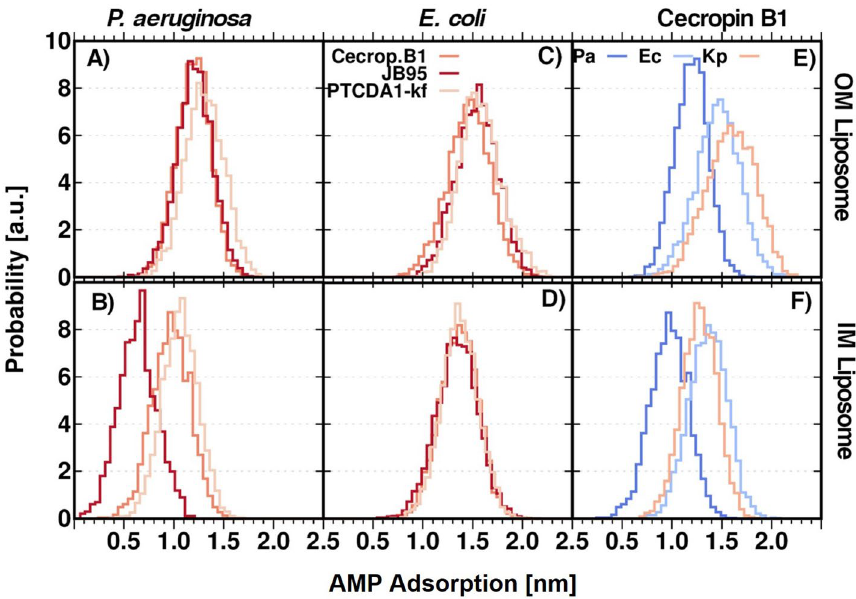
Figure 6. AMP Interfacial adsorption depth on: ( A – B ) P. aeruginosa OM and IM liposomes respectively; ( C – D ) E. coli OM and IM liposomes respectively. ( E – F ) Cecropin B1 adsorption depth of various OM and IM liposomes. Analysis performed on the last μs of the MD production. [*Image: “adsorption” corrected].